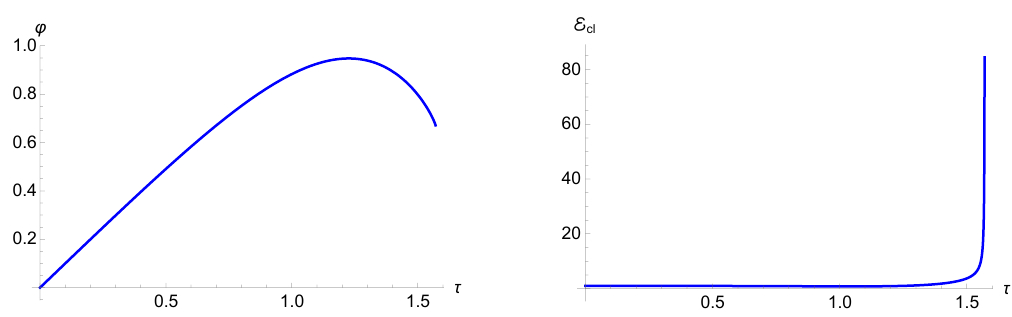
whilst the energy diverges at this 2